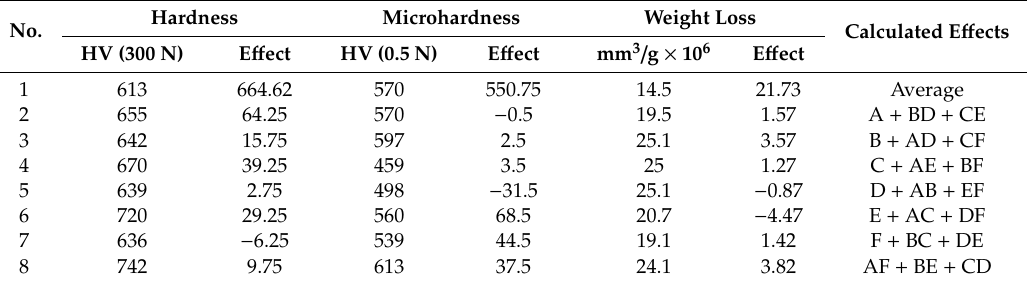
Table 5. Analysis of the e ff ects of interactions AE and BF on the hardness of the